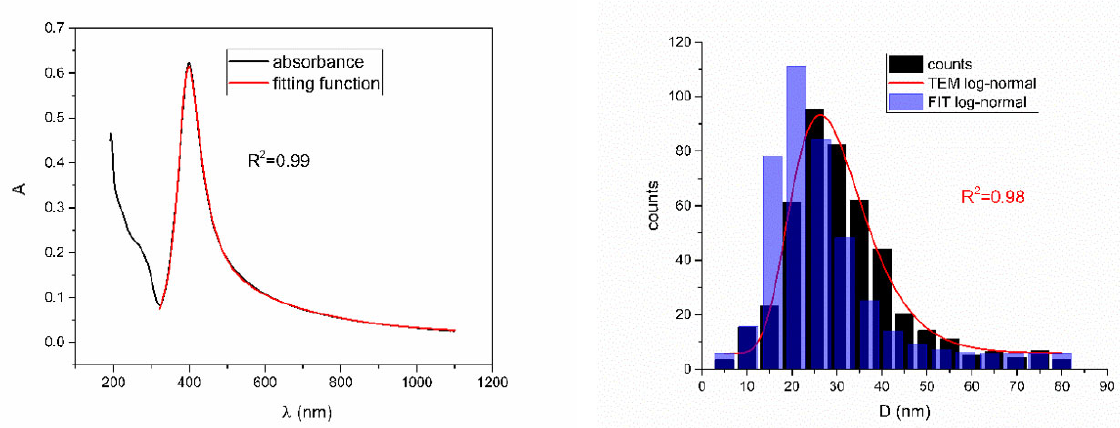
Figure 9. UV-Vis spectrum with fitting function ( left ) for sample AgIn_1. Reported and reconstructed